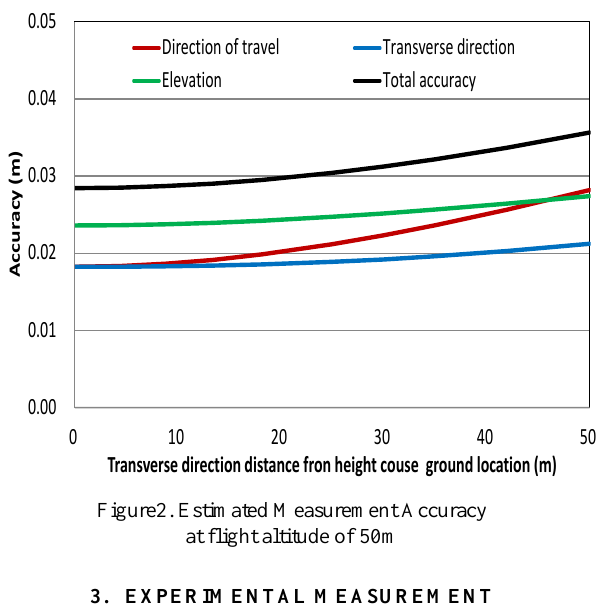
Figure2. Estimated Measurement Accuracy at flight altitude of 50m